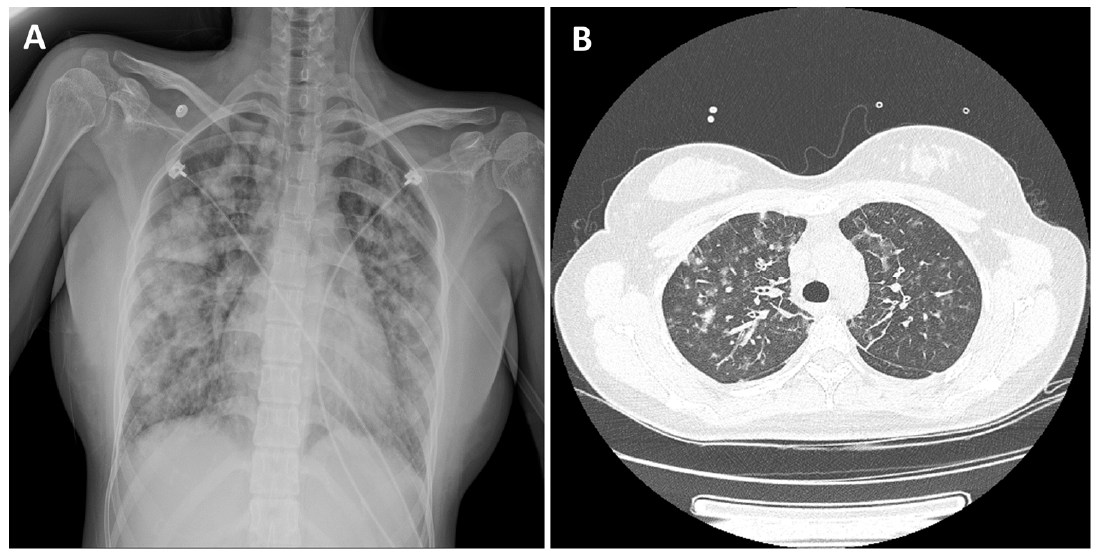
Figure 1. Initial imaging findings of a patient with acute eosinophilic pneumonia. ( A ) Chest radio- graph revealing a bilateral patch of pulmonary infiltration. ( B ) Chest computed tomography revealing bilateral multifocal patchy consolidations with multiple small nodular ground-glass opacities and smooth interlobular septal thickening.